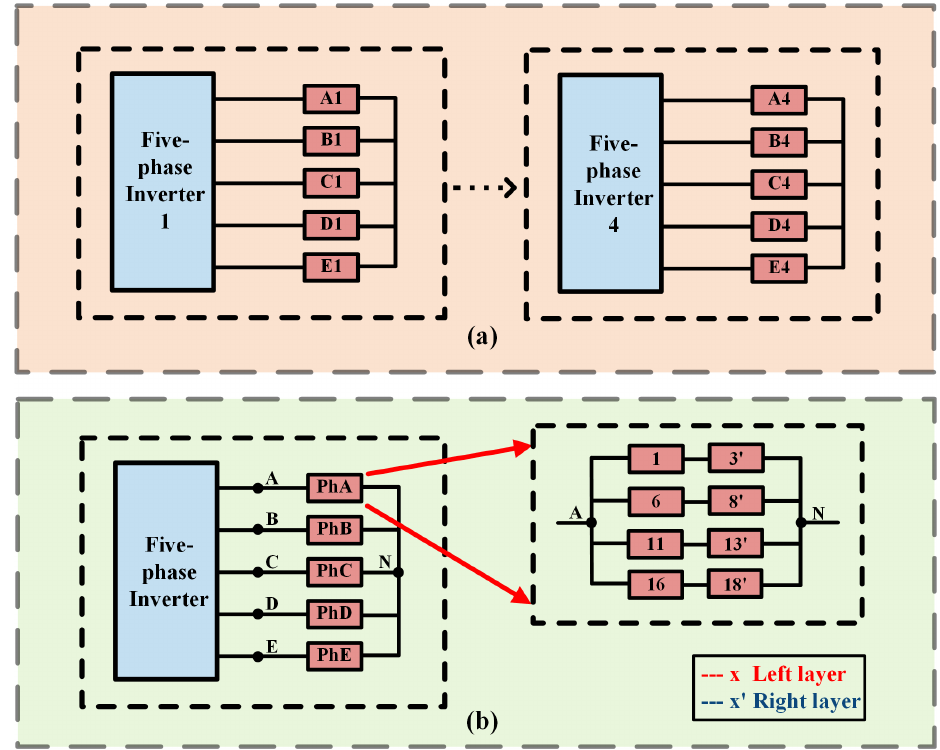
Figure 3. ( a ) Winding connection of five-phase single-turn PMSM. ( b ) Winding connection of dis- tributed five-phase PMSM.